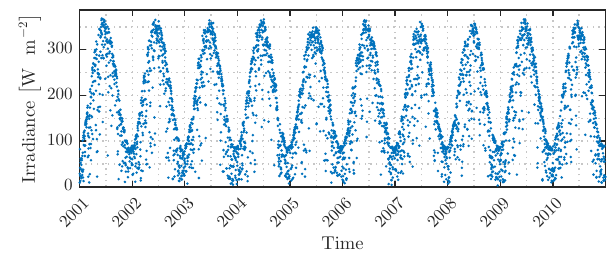
Figure 1. The ten year time-series of SSI under study, span- ning 2001 through 2010. Each point corresponds to a daily mean of irradiance. Time markers on the abscissa denote the start of the corresponding